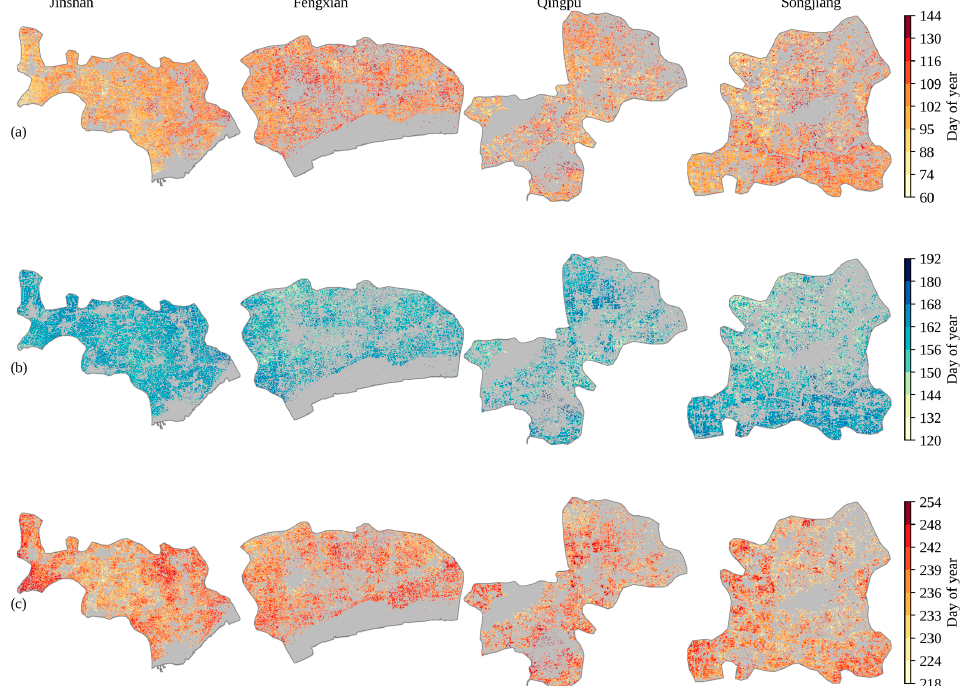
Figure 4. Maps of long-term mean phenological metrics in the four counties of Shanghai. Each column in the figure indicates one of the four counties. ( a ) maps of peak of first cropping cycle (POS1). ( b ) maps of start of second cropping cycle (SOS2). ( c ) maps of peak of second cropping cycle (POS2). Gray regions represent missing data and non-crop areas.